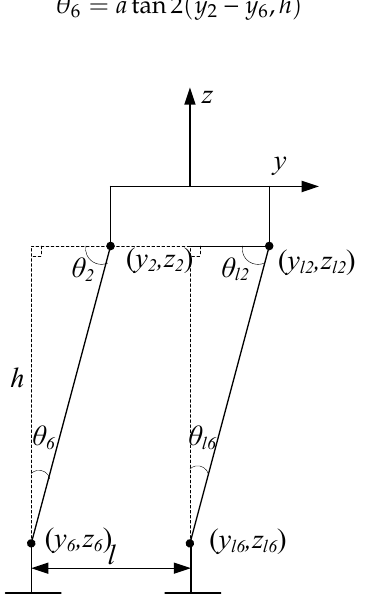
Figure 8. Sagittal plane geometric relationship diagram.